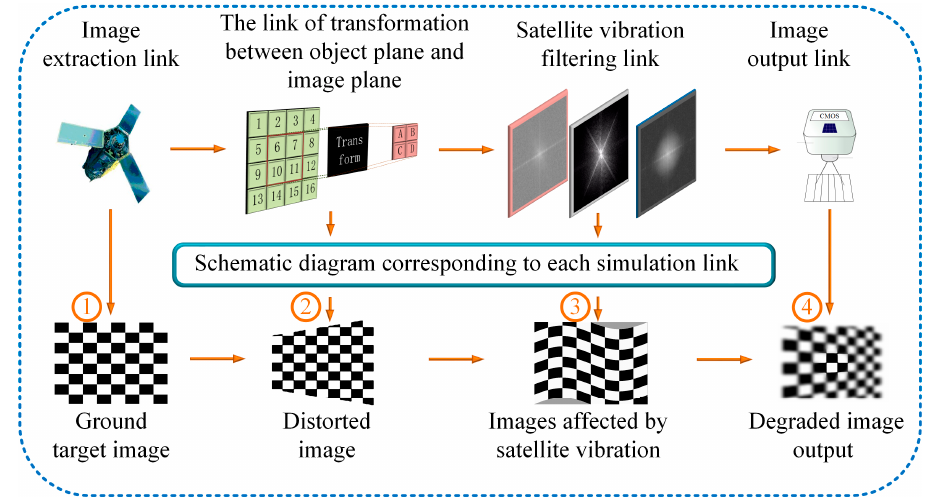
Figure 2. Simulation link for dynamic imaging.